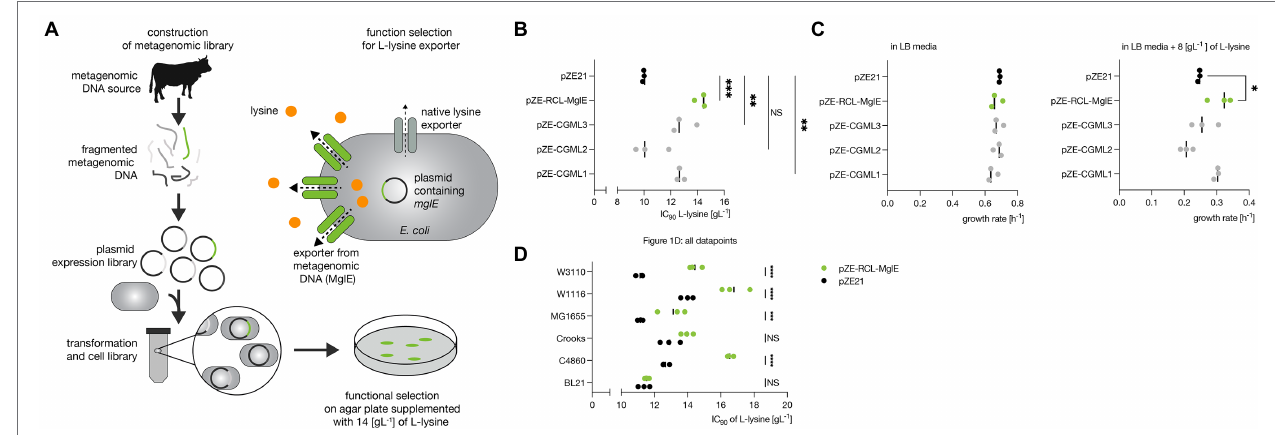
FIGURE 1 | Functional metagenomic screening and Lysine tolerance of the screened metagenomics clones. (A) Functional metagenomic screening for lysine transporters. Cow fecal metagenomic DNA library construction and its functional selection for L-lysine exporters. (B) L-lysine IC90 values for the selected E. coli C4860 resistant clones harboring putative transporters. A one-way ANOVA with Dunnett’s multiple testing correction of the L-Lysine IC90 was applied to compare the metagenomic inserts vs. the empty vector (pZE21). (C) The growth rates of E. coli C4860 harboring pZE-RCL-MglE and pZE21 (control) in LB-Km and LB-Km supplemented with 8 gl − 1 of L-lysine. A one-way ANOVA with Dunnett’s correction for multiple testing was used to compare the growth rate of the metagenomic gene inserts vs. the empty vector (pZE21). A significantly different of growth rate ( p = 0.0375) was found between MglE and the empty vector control pZE21 at 8 gl − 1 of L-lysine. (D) Improved L-lysine tolerance (IC90 values) by expression of metagenomics insert carrying MglE transporter in industrially relevant E. coli strains. A two way ANOVA with Bonferroni correction for multiple testing of the IC90 values was applied per background strain comparing the empty vector (pZE21) against MglE metagenomic insert (pZE-RCL-MglE). In C4860, MG1655, W1116 and W3110 there was a significant difference between the empty vector and MglE ( p = <0.0001). For BL21 and Crooks, no significant difference was found ( p >